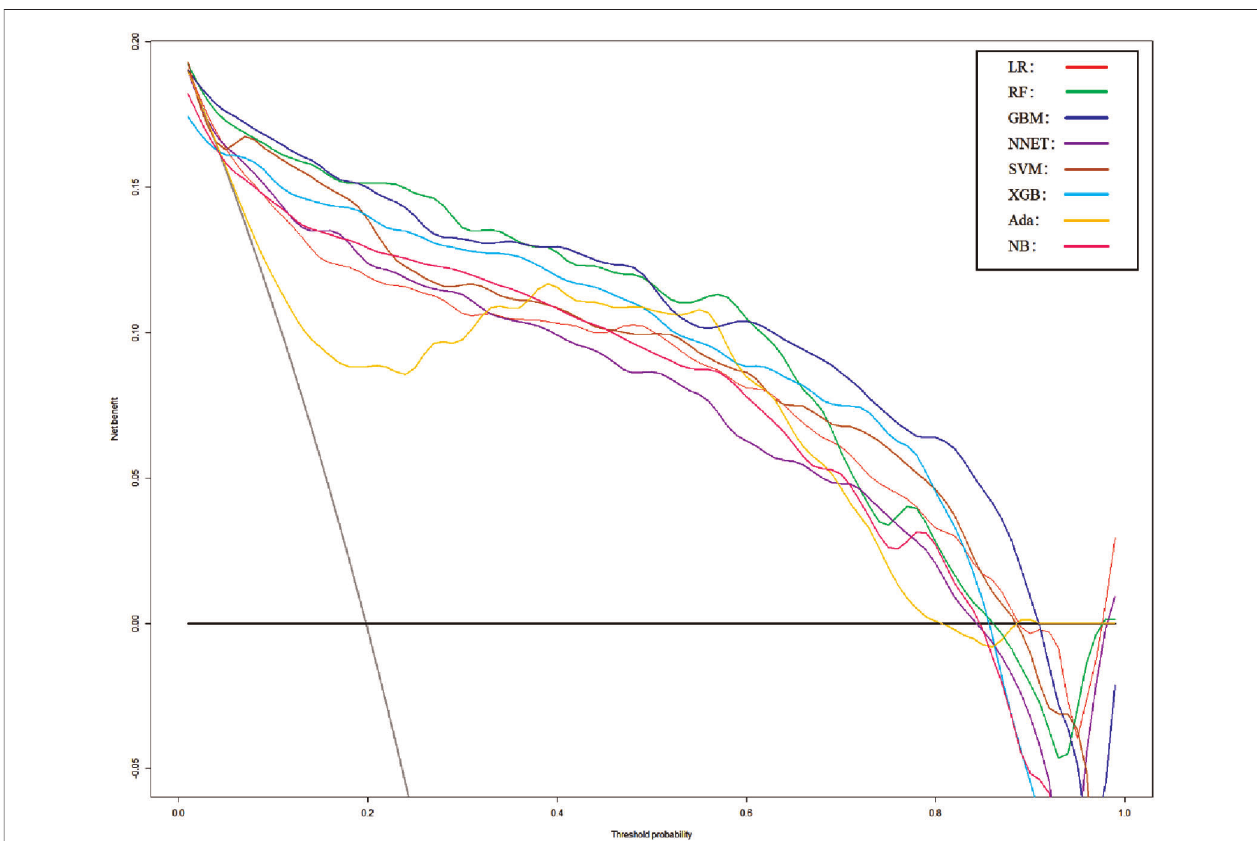
FIGURE 5 | Decision curve analysis of Model1. LR, logistic regression; RF, random forest; GBM, gradient boosting machine; NNET, arti fi cial neural network; SVM, support vector machine; XGB, eXtreme gradient boosting; Ada, adapting boosting; NB, naïve Bayes; Model1 was adjusted for GCS, glucose, sodium, chloride, SPO 2 , bicarbonate, temperature, white blood cell (WBC), heparin use, and SOFA